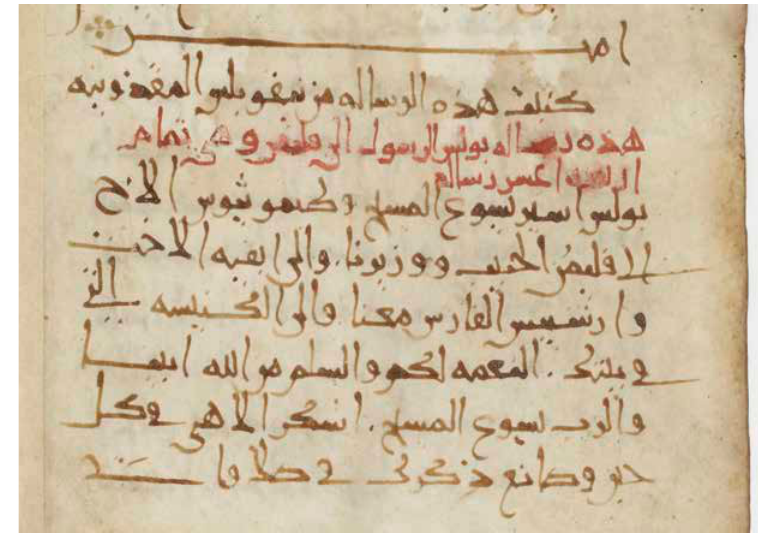
Figure 1. Paris BnF arabe 6725 folio 9v Beginning of Philemon © Bibliothèque nationale de France For Paris BnF grec supplément 911, an 11th century Greek-Arabic codex of the Gospel of Luke, Gallica offers only images of the